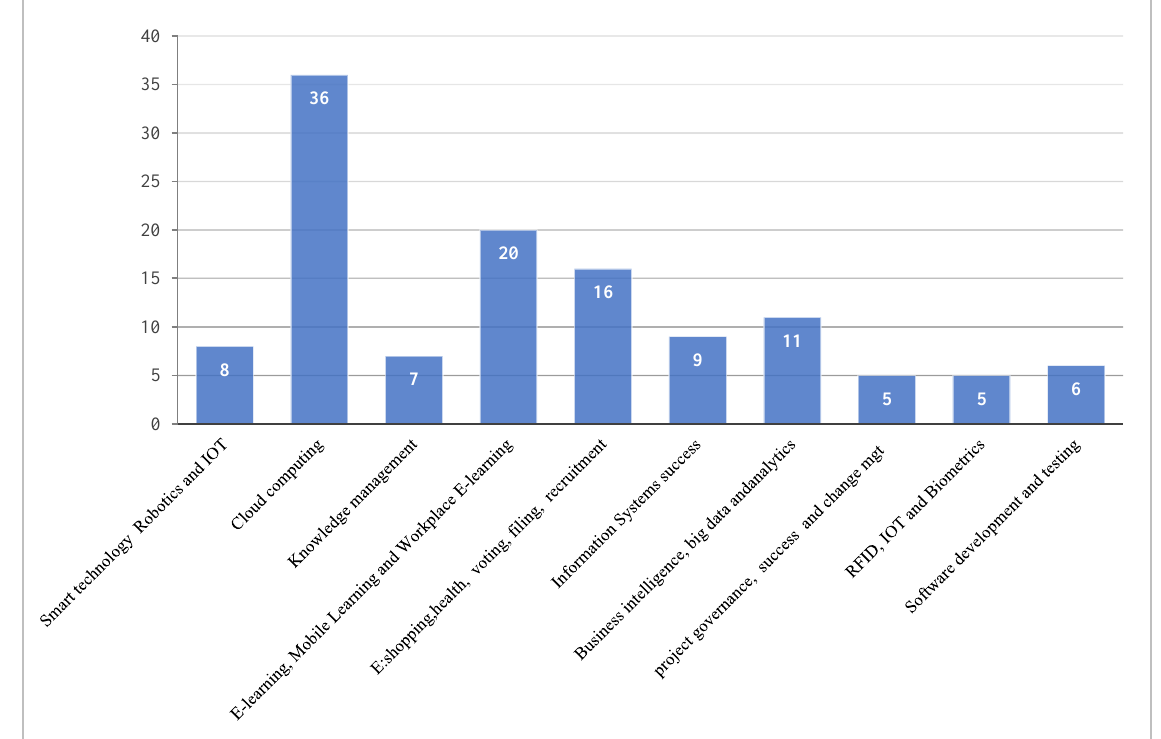
Figure 4. Ten (10) most selected topics by